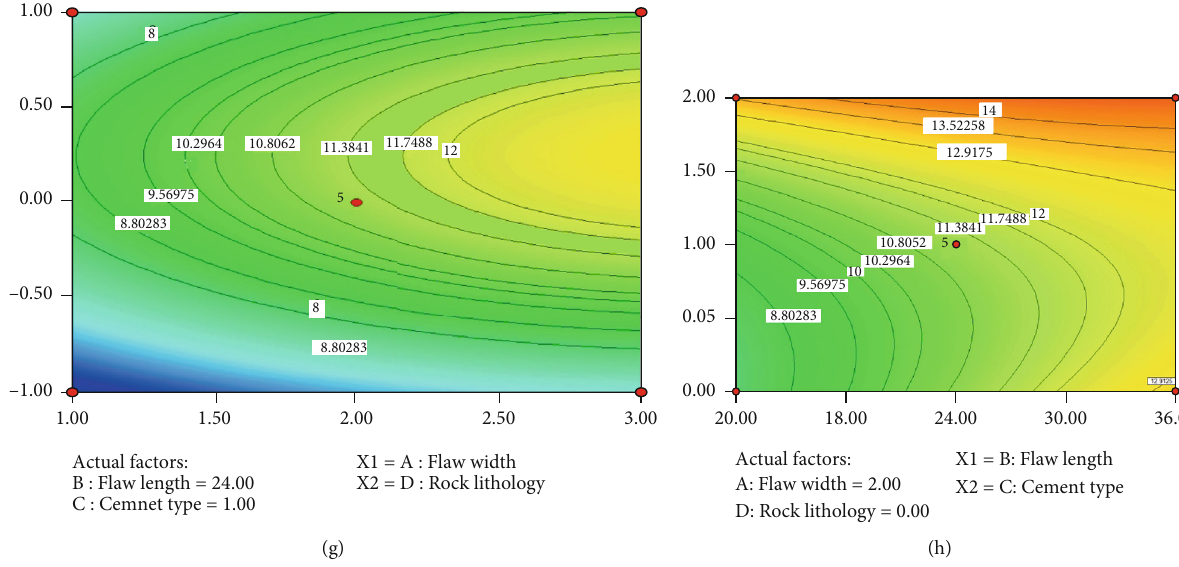
Figure 8: Response of the in fl uential factors on frost heaving force. (a – d) 3D response surface analysis of the in fl uence of the four factors on frost heaving force. (e – h) 2D contour of the in fl uence of the four factor on frost heaving